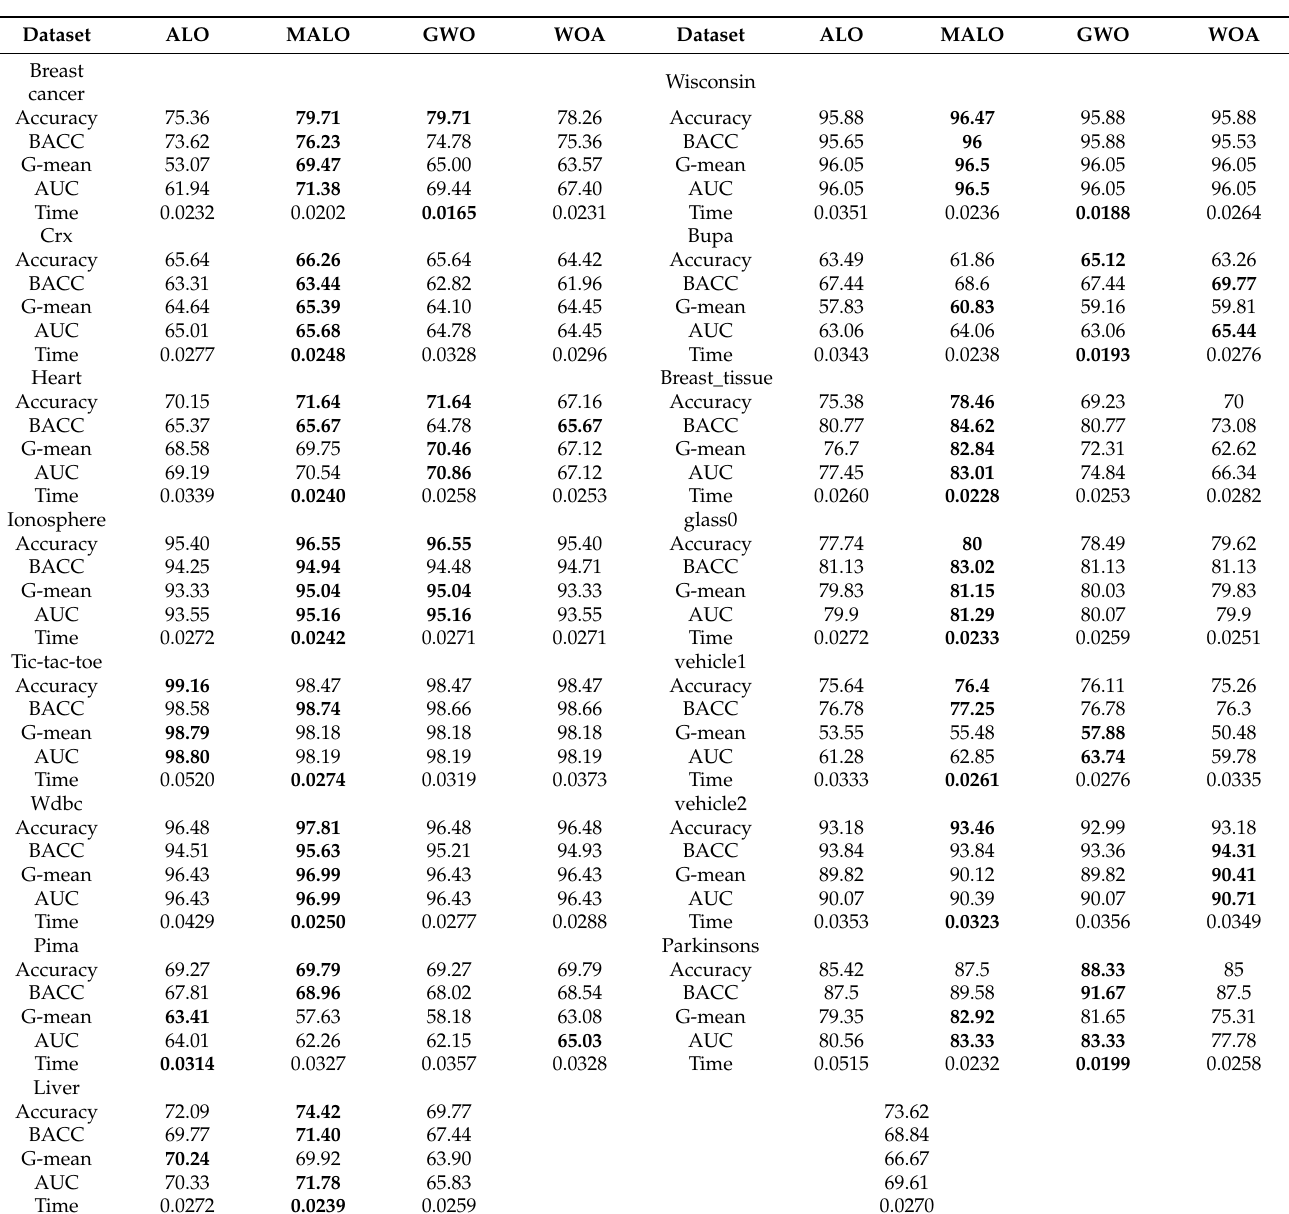
Table 9. Performances of MALO, ALO, GWO, and WOA on balanced and imbalanced real- world